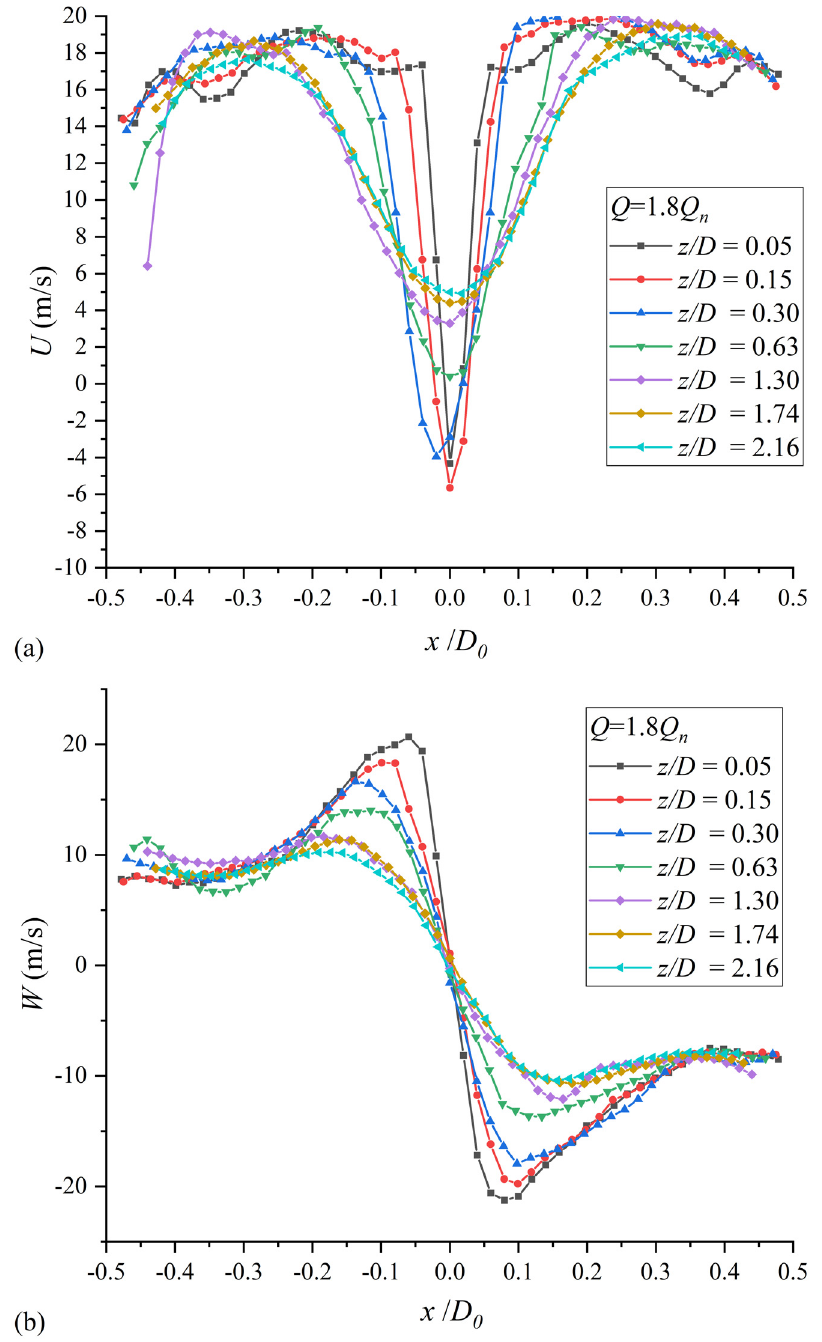
Figure 7. Time-averaged velocity profiles at different distances from the runner at a constant runner speed ω n : ( a ) Axial component; ( b ) Tangential component. Overload operating regime with Q = 1.8 Q n . At z/ D = 1.30, S = –0.35.